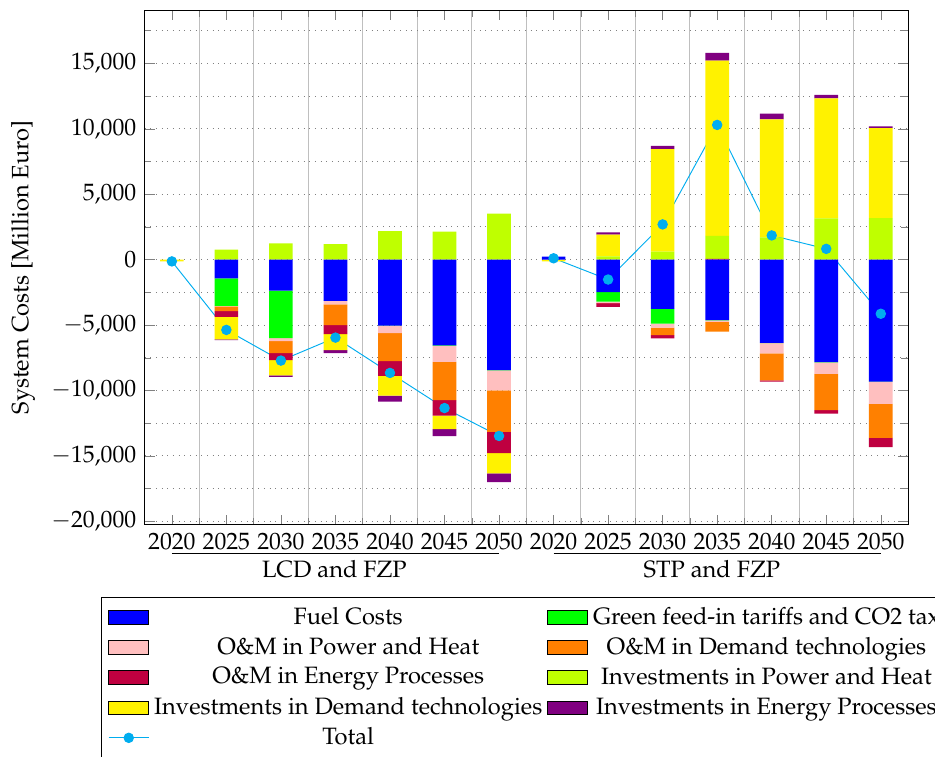
Figure 10. Cost difference between scenarios.